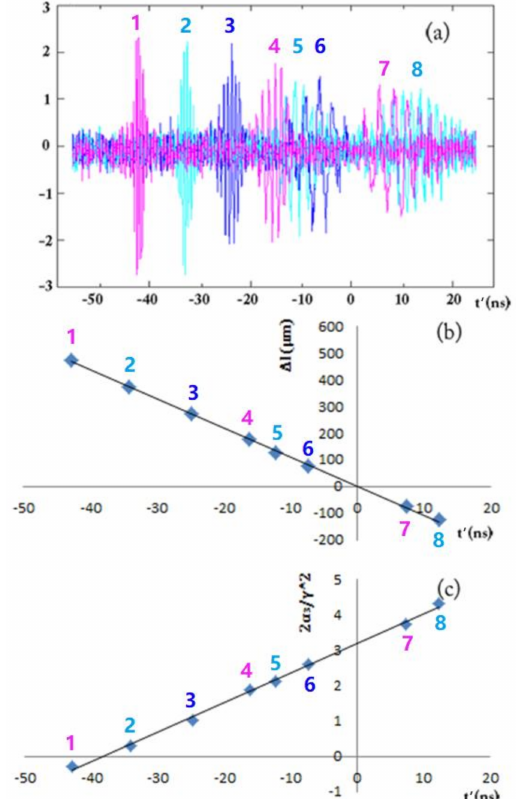
Figure 4. The measurement of the dispersion of 10 km SMF. ( a ) The signal at different t (cid:48) , different colors and numbers are used for signals at different t (cid:48) ; ( b ) the relationship between the optical path difference ∆ l and t (cid:48) , the linearity between ∆ l and t (cid:48) is 0.999; ( c ) the relationship between the resolution expansion and t (cid:48) , the linearity between α 3 and t (cid:48) is 0.999.